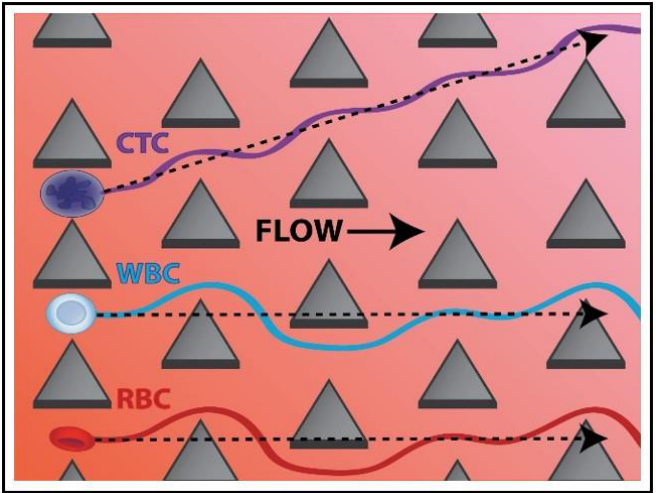
Figure 4. CTCs isolation based on DLD technique with triangular micro-posts, reprinted with per- mission from [46], Copyright 2012, AIP Publishing LLC.